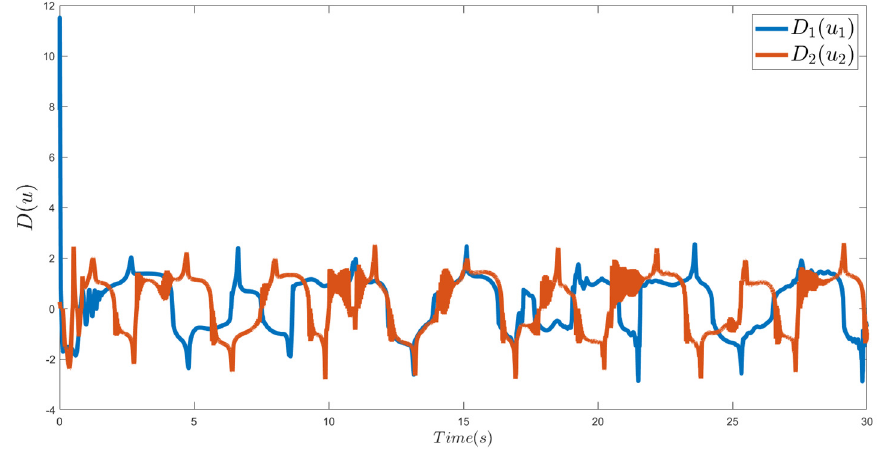
Figure 5. Control inputs.